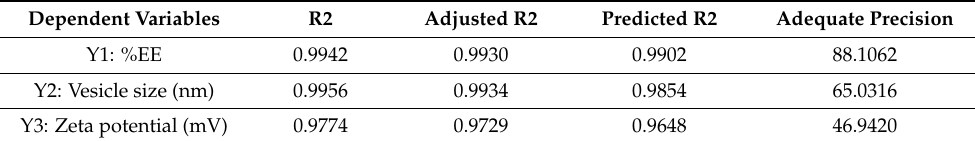
Table 3. Output data of I optimal design of ROS-loaded TESMs.